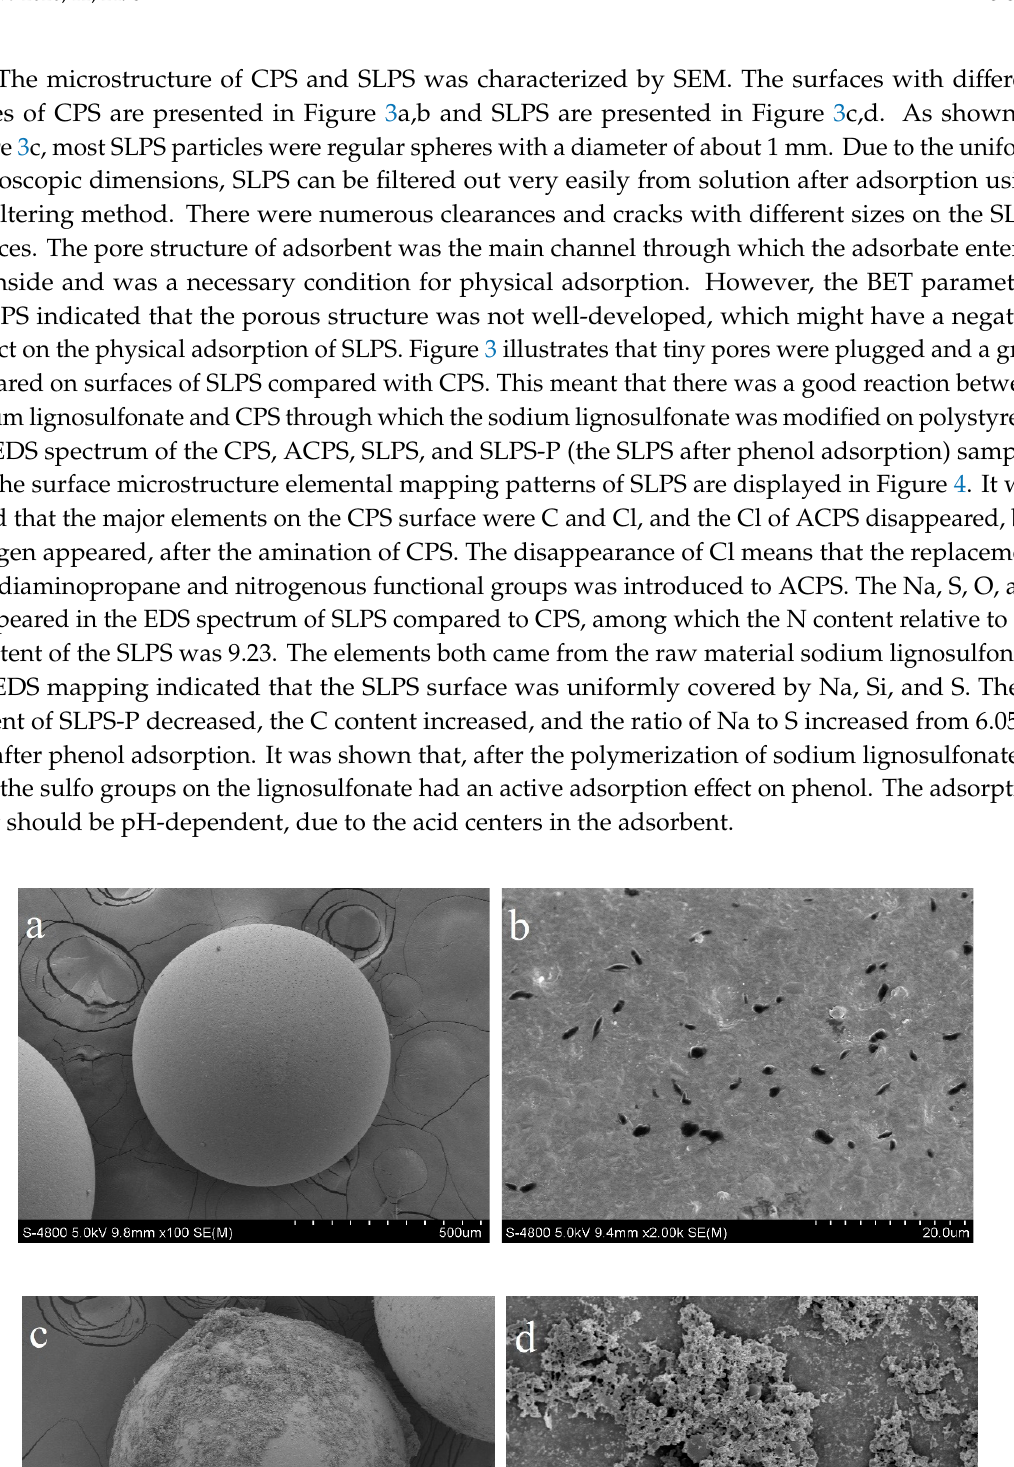
Table 1. Porous structure parameters of samples.